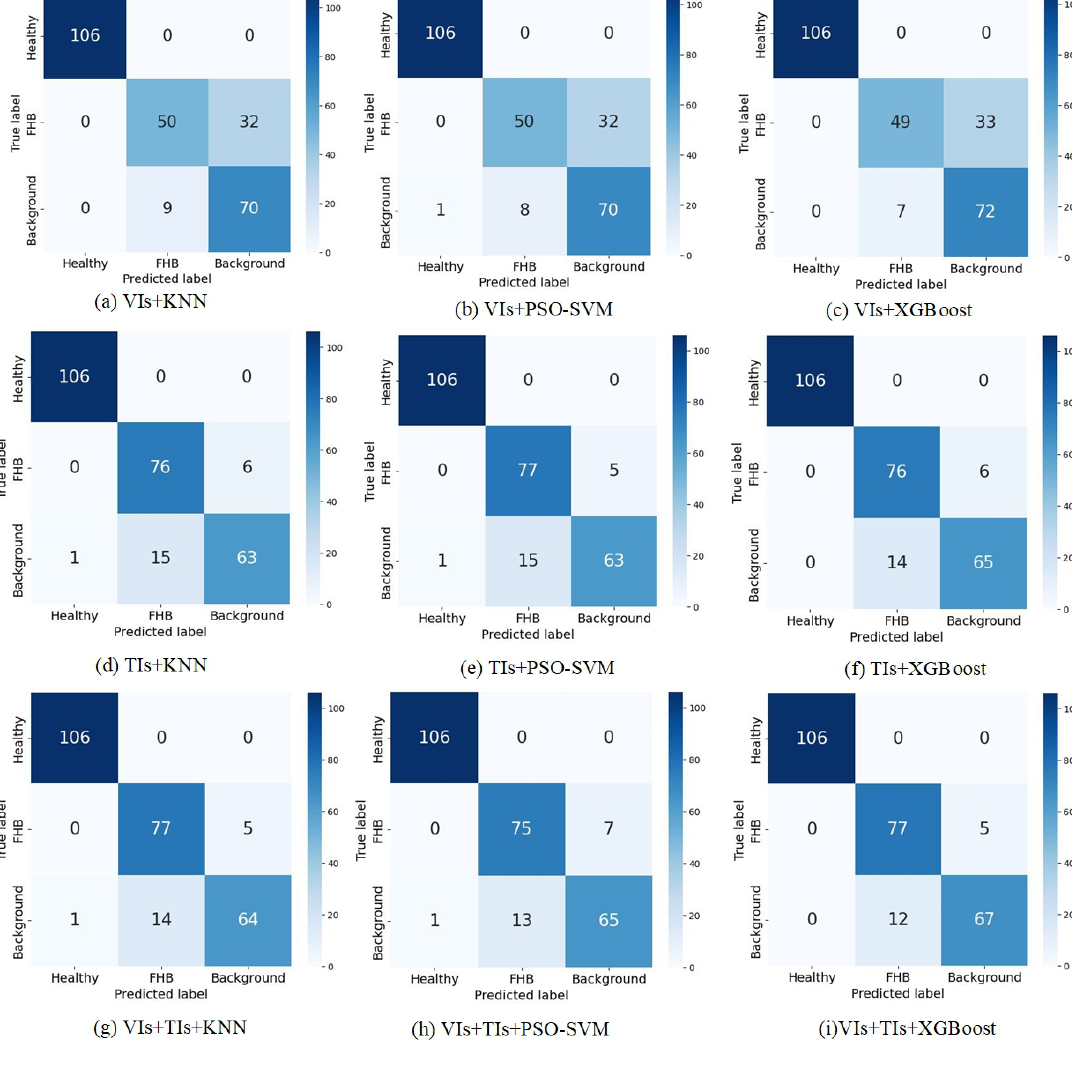
Figure 4. Confusion matrix for the three models with different inputs.